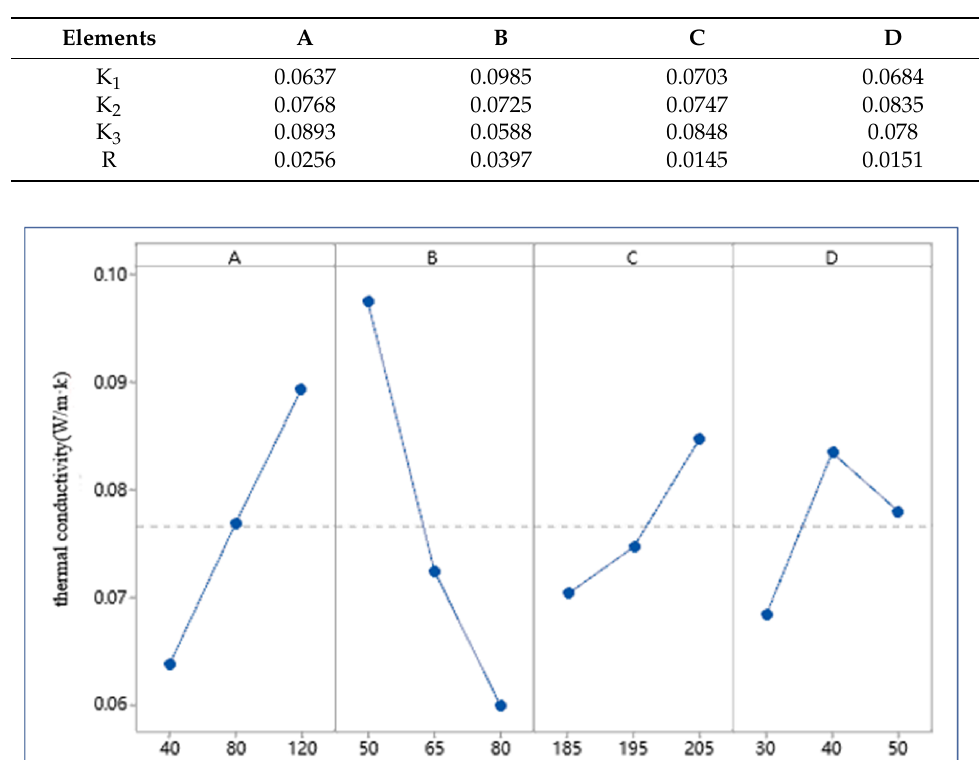
Figure 8. Effect of factors at different levels on thermal conductivity: ( A ) Mesh. ( B ) Proportion. ( C ) Temperature. ( D ) Time.